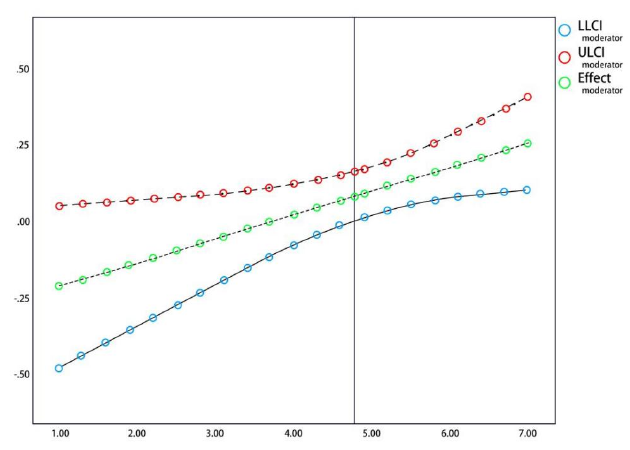
Figure 3. The moderating interval of social media interaction on the relationship between cultural identity and brand value.